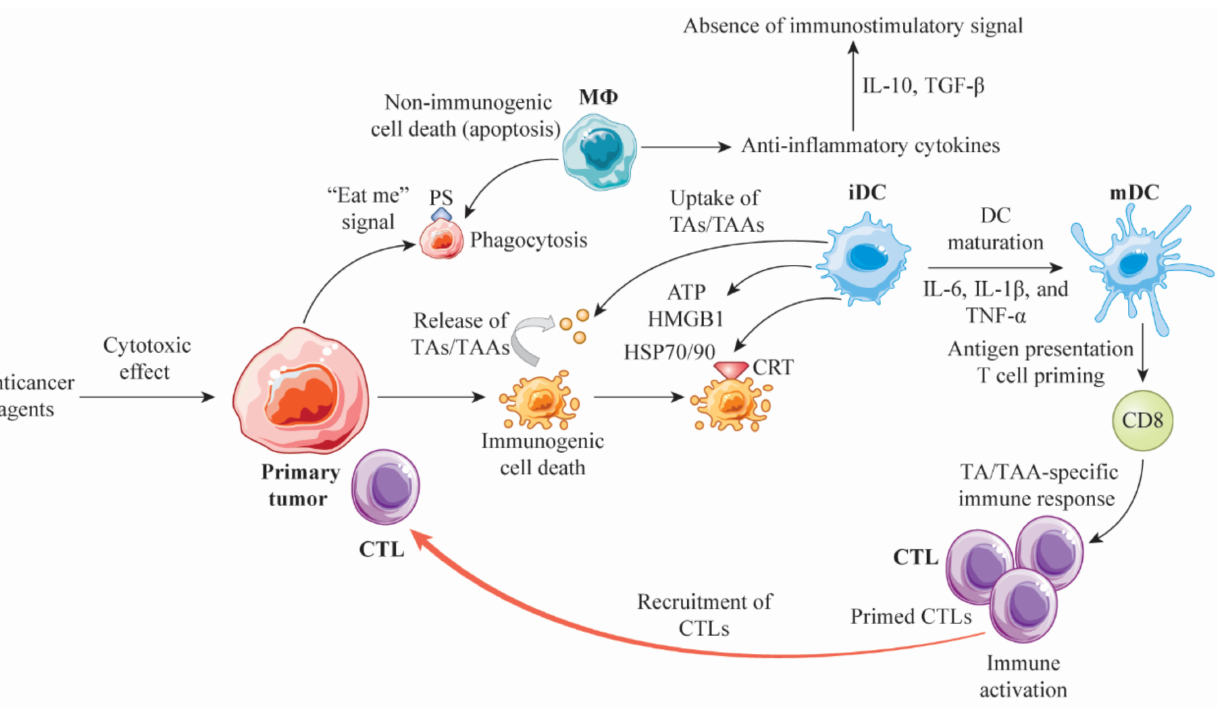
Figure 1. Non-immunogenic and immunogenic cell death caused by anticancer agents. Anticancer agents kill tumor cells via cytotoxic effects. PS externalization in apoptotic cells generates an “eat me” signal, leading to engulfment by macrophages; anti-inflammatory cytokines, such as TGF- β and IL-10, are released, suppressing the immunostimulatory response. In tumor cells dying due to the administration of anticancer drugs, CRTs are exposed on the membrane; DAMPs, such as HMGB1, ATP, and HSP70/90, are released; and pro-inflammatory cytokines, such as IL-1 β , IL-6, and TNF- α , are released prior to apoptosis, resulting in the induction of an antitumor immune response known as immunogenic cell death. TAs and TAAs released from dying tumor cells are engulfed by iDCs and then activated into mDCs, which present TAs and TAAs to CD8+ T cells and produce tumor-specific CTLs in tumor-draining lymph nodes. Activated CTLs are recruited into the primary site and lyse the tumor cells. Abbreviations: M φ , macrophage; IL, interleukin; TGF- β , transforming growth factor β ; PS, phosphatidyl serine; TA, tumor antigen; TAA, tumor-associated antigen; iDC, immature dendritic cell; DC, dendritic cell; mDC, mature dendritic cell; ATP, adenosine triphosphate; HMGB1, high mobility group box 1; HSP, heat shock protein; TNF- α , tumor necrosis factor- α ; CTL, cytotoxic T lymphocyte; CRT, calreticulin; DAMP, damage-associated molecular